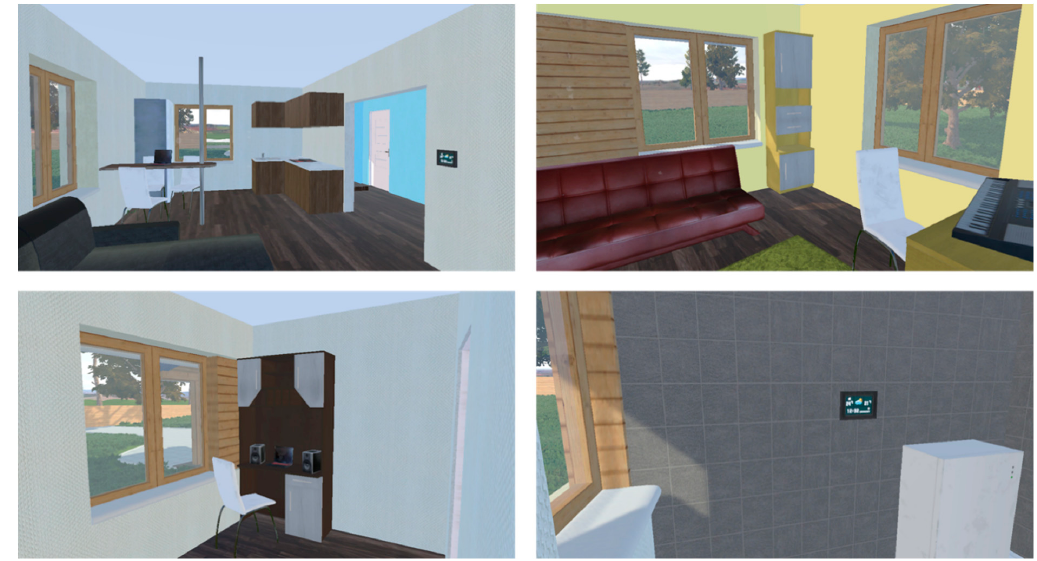
Figure 2. Interior view of the 3D BIM model.